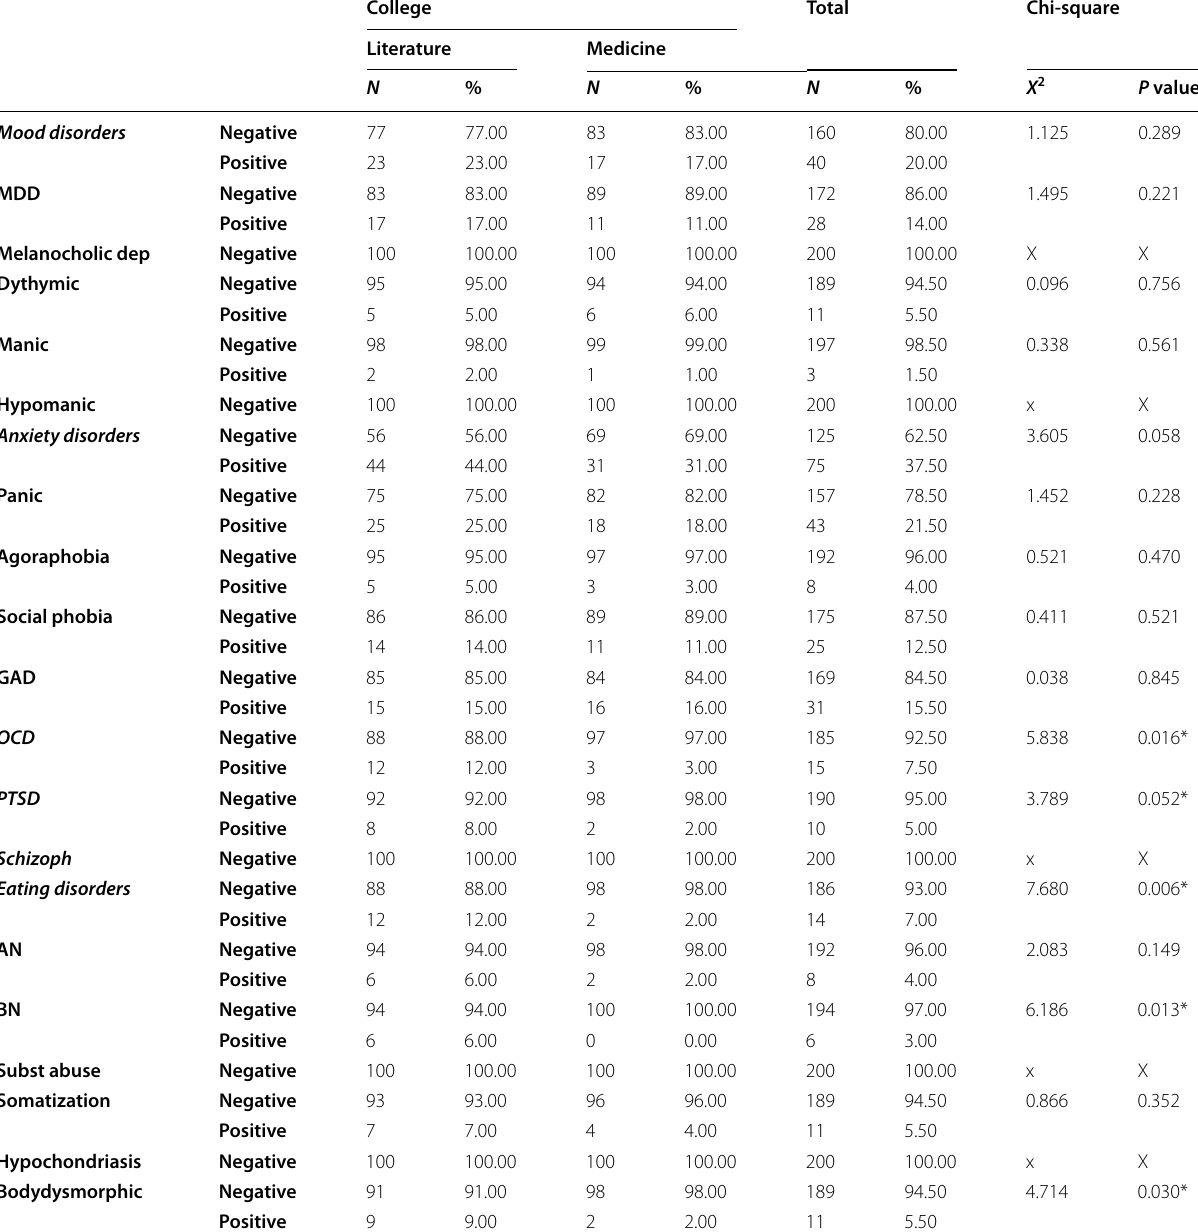
Table 2 Descriptive data for all psychiatric disorders using